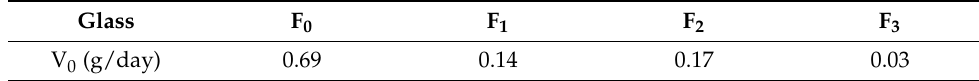
Table 5. Initial dissolution rate of F 0 , F 1 , F 2 , and F 3